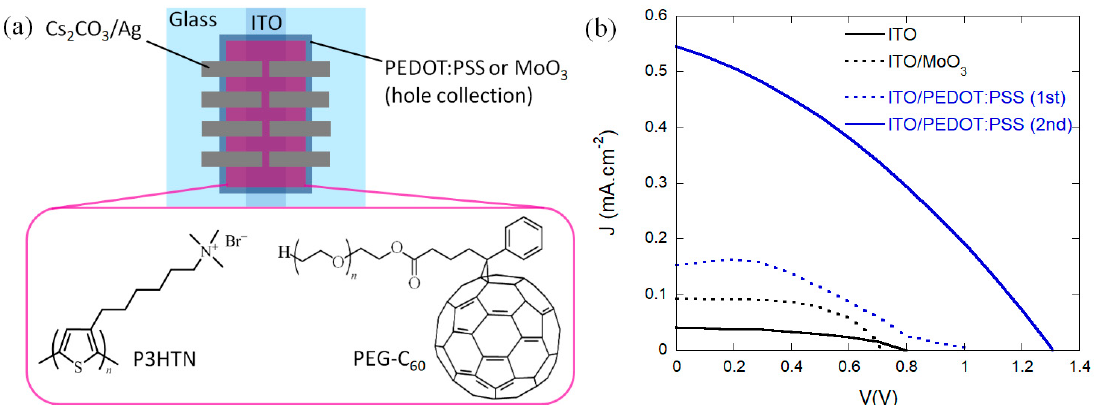
Figure 1. ( a ) Schematic representation of the organic solar cell (OSC) architecture and the molecular structures of the active materials; ( b ) current density-voltage ( J - V ) characteristics of OSC-Ref (solid black line), OSC-MoO 3 (dashed black line), with the first (dashed line) and second (solid line) scans of OSC-PEDOT:PSS (blue lines) under 1 sun.